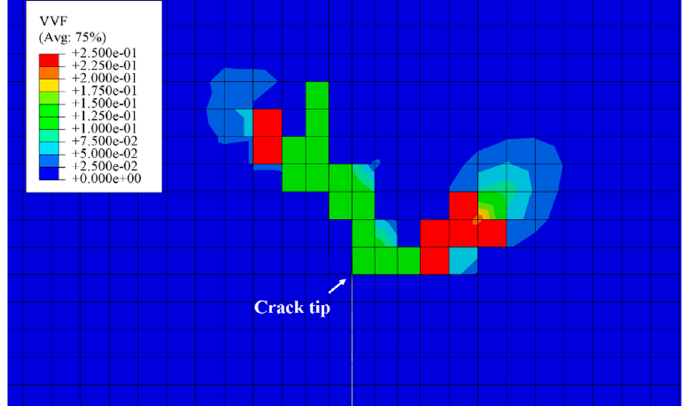
Figure 7. The crack bifurcation phenomenon when the M s = 1.4.